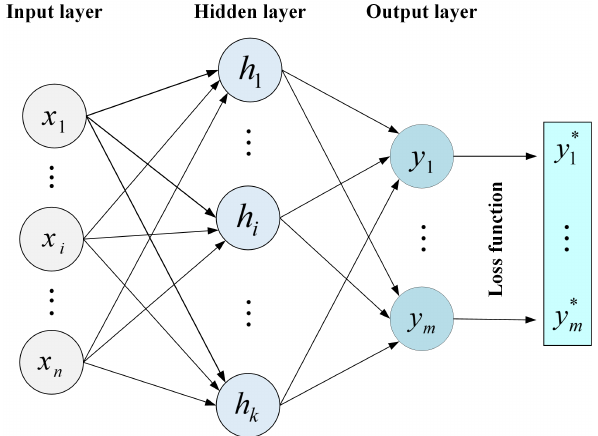
Figure 2. The structure of the MLP. It has n input values and m output values, including k hidden units. x n is the input value. The direction of the arrow is the direction in which the input value is transmitted. The hidden unit is h k , it receives the input value of the previous layer. y m is the output unit, and the real value is y ∗ m